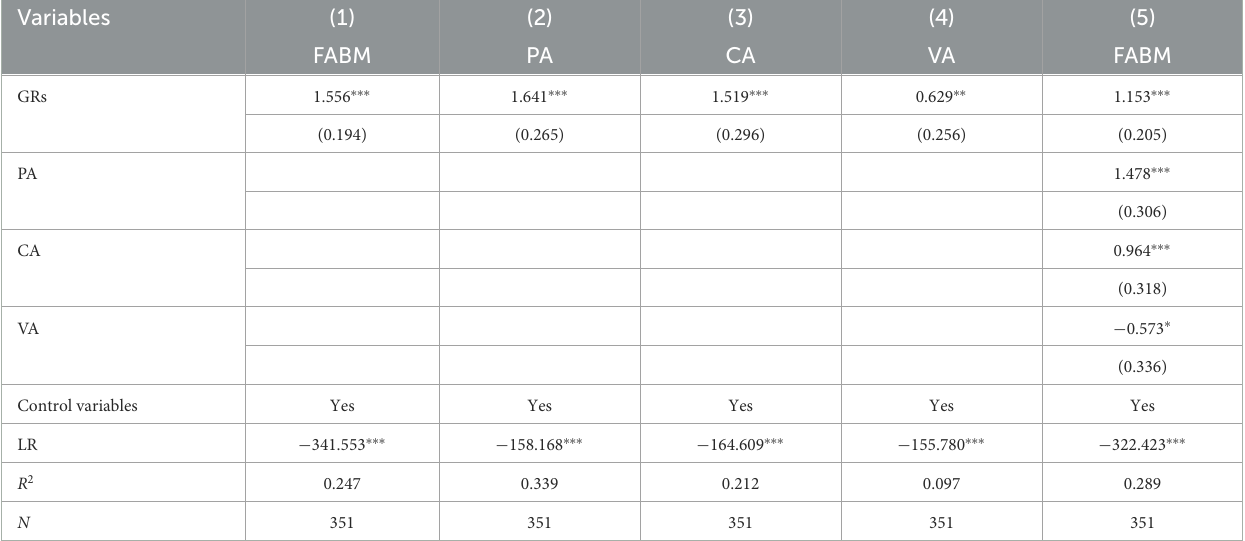
TABLE 4 Mediation effect test results.